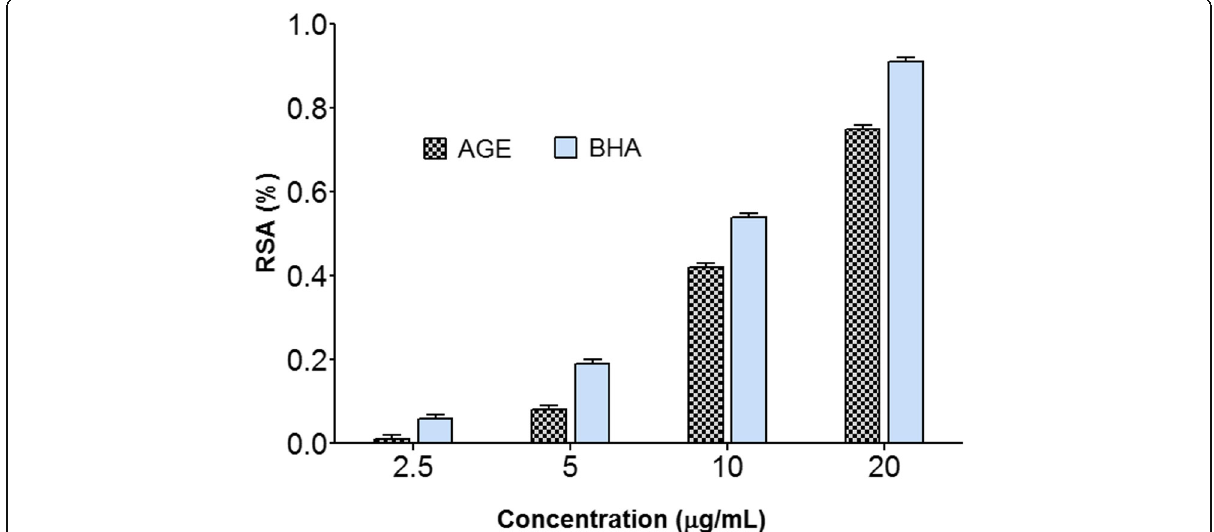
Fig. 1 Radical scavenging activity of aqueous garlic extract (AGE) at different concentrations. Graph showing concentration-dependent radical scavenging activity of AGE ( p < 0.0001; F = 650.85). Each value represents mean ± Standard Error of Mean ( n = 3); RSA = radical scavenging activity; AGE = aqueous garlic extract; BHA = butylated hydroxyl anisole